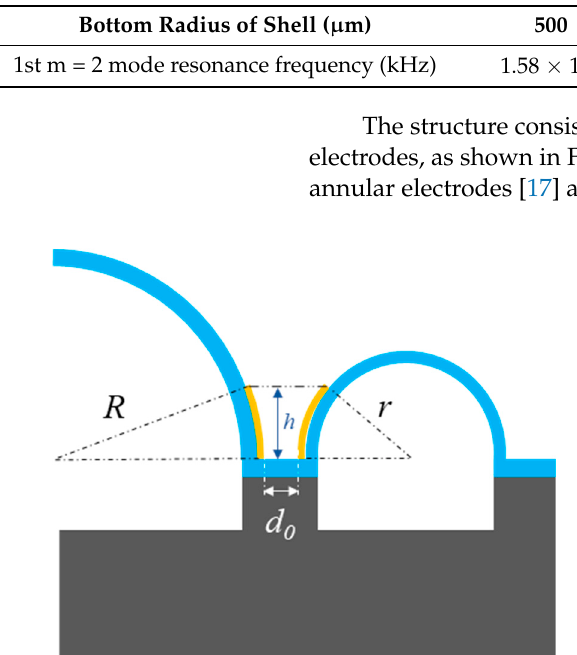
Figure 3. 1st m = 2 mode of HRG ( a ) inclined view ( b ) overview. Table 2. Resonance frequency of shell with different radius.